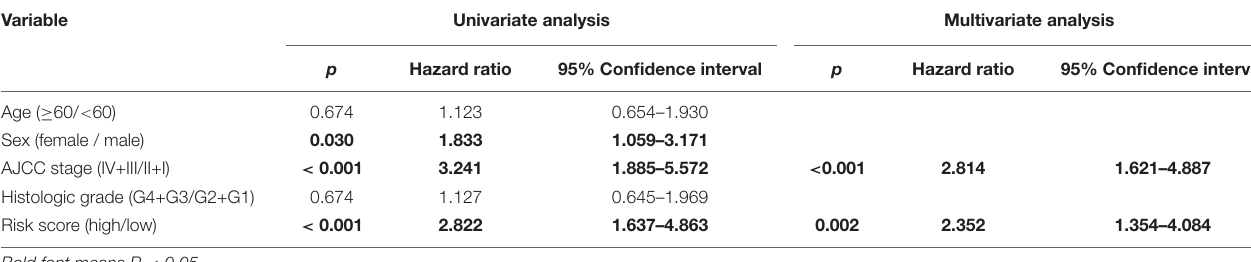
TABLE 4 | Univariate and multivariate Cox regression analyses in the testing group.